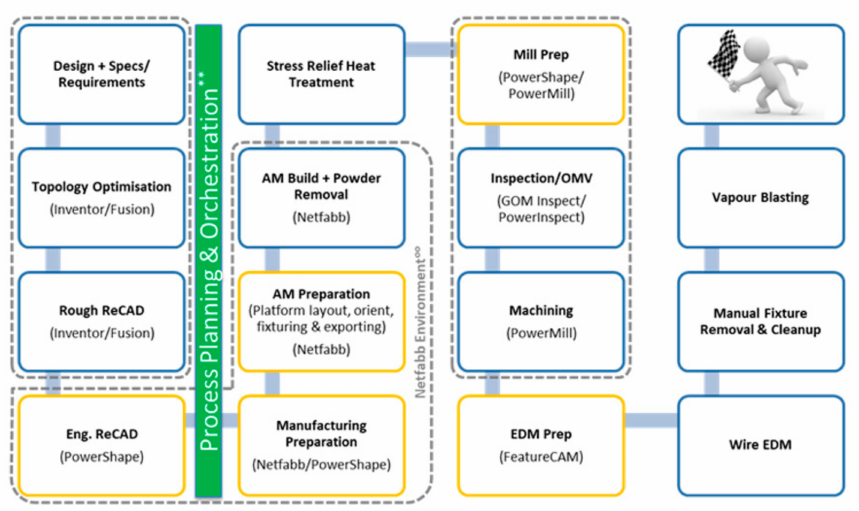
Figure 9. Modelling for AM ICT framework based on AUTODESK software and